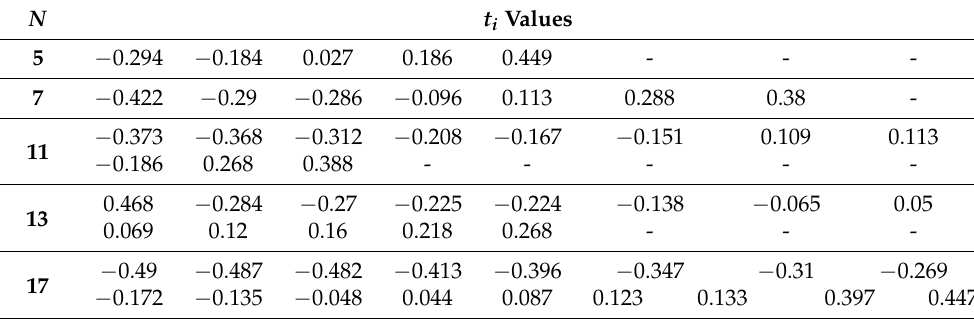
Table 3. Sets of t i values (normalized by τ ) with the best nadir echo suppression performance for primes N between 5 and 17.